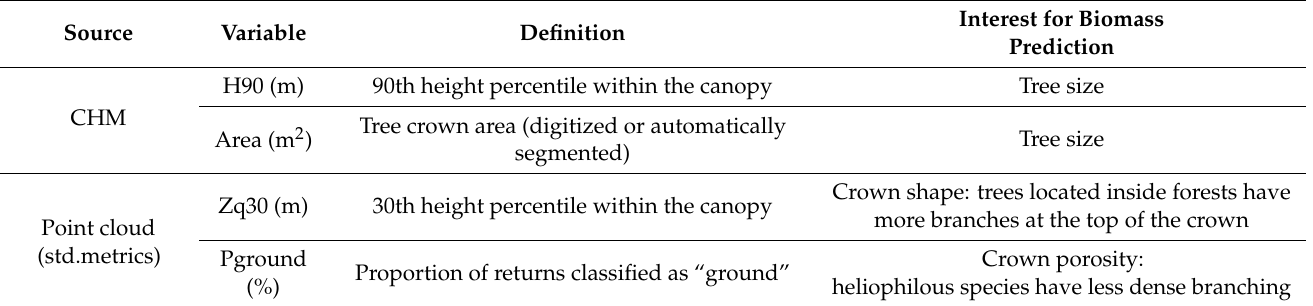
Interest for Biomass Prediction Tree size Tree size Crown shape: trees located inside forests have more branches at the top of the